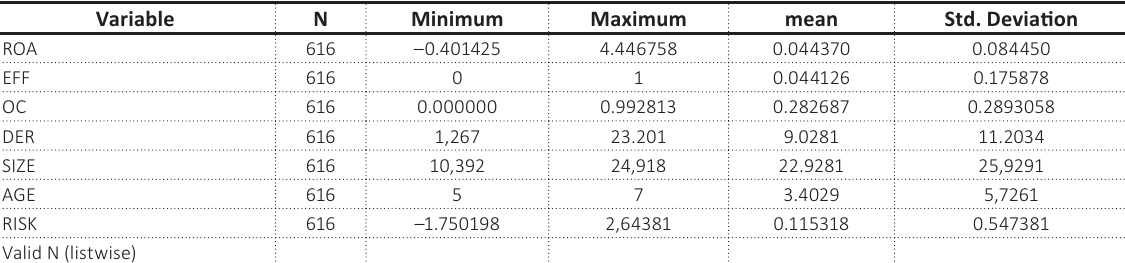
Table 3. Descriptive